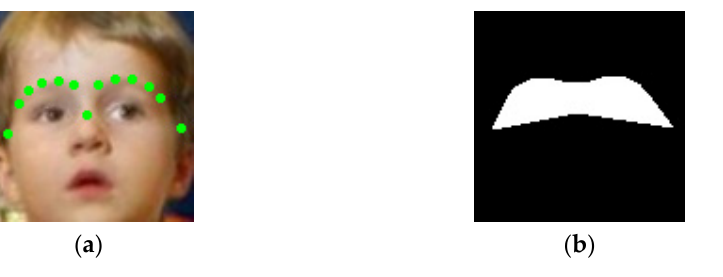
Figure 6. Schematic diagram of eye area matrix generation. ( a ) Locating key areas of the human eye. ( b ) Generating a human eye area mask.